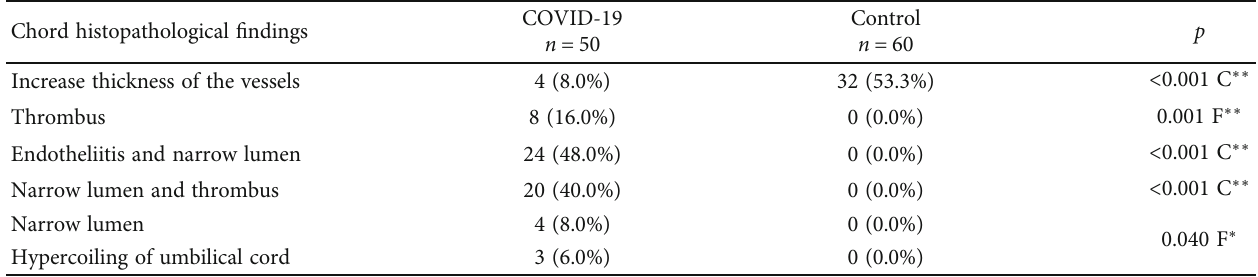
Table 2: Comparison of umbilical cord histopmorphological fi ndings between COVID-19 group and control group. Chord histopathological fi ndings